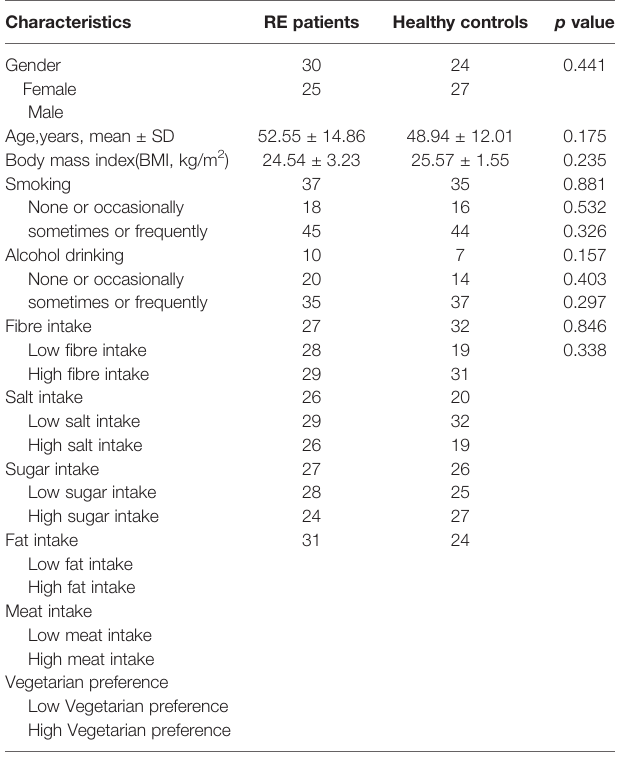
TABLE 1 | Clinical characteristics of Re fl ux Esophagitis (RE) patients and healthy controls.